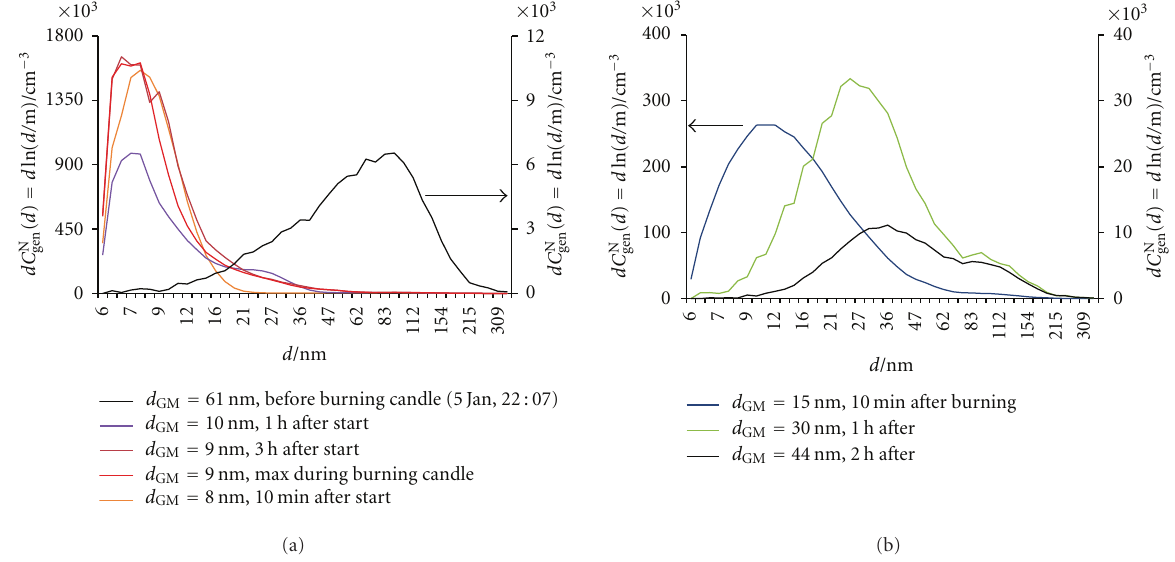
Figure 20: Number size distributions (d C N ( d ) = dln( d/ m)) of general aerosol particles in indoor air (a) before and during burning of a gen candle and (b) after burning a